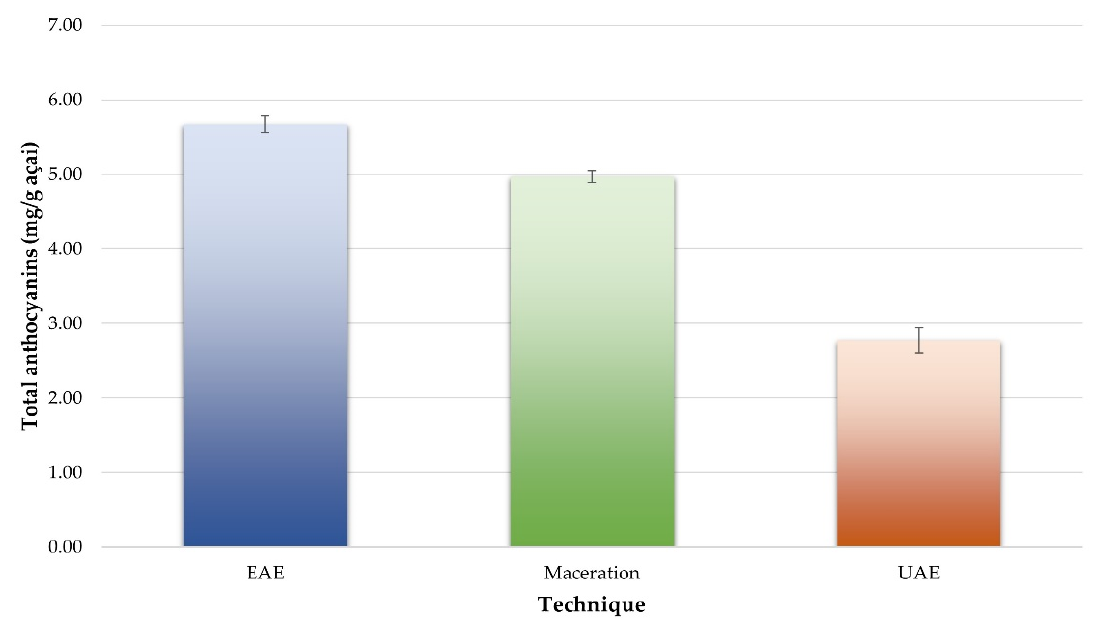
Figure 5. Total anthocyanin concentrations (mg/g açai) obtained by EAE, maceration and UAE ( n = 4).